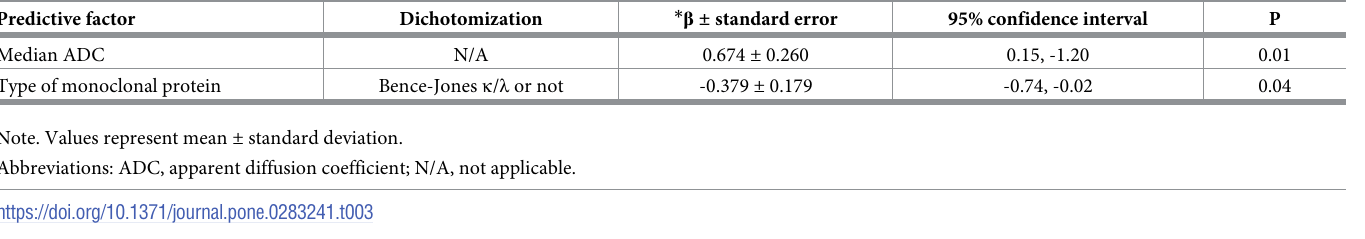
Table 3. Predictive factors significantly associated with relatively poor mobilization by multivariate analysis. Predictive factor